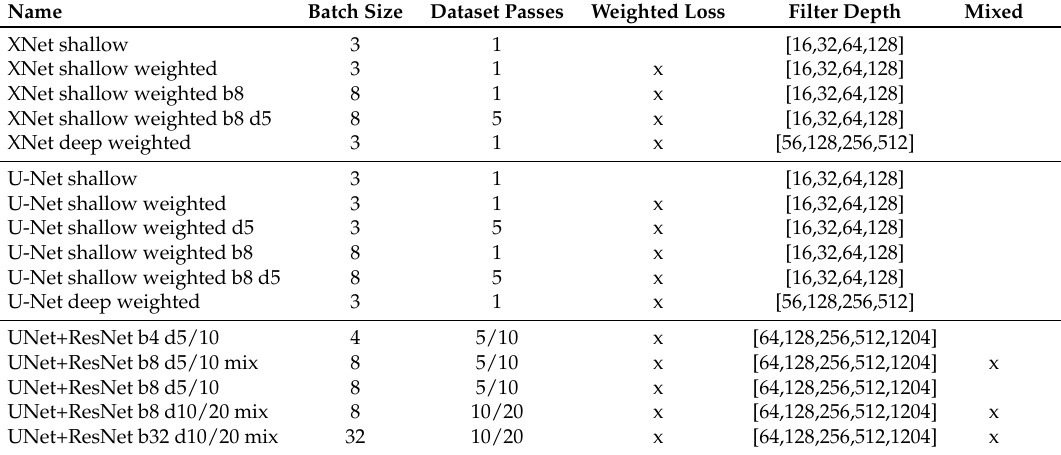
Table 3. Hyper-parameter tuning experimental setups for different architectures. Here we vary the batch size, number of times the training dataset is passed to the model during training (For the XNet and U-Net models, this number refers to the number of times the entire training dataset was passed to the model during training before Early Stopping was implemented. For the U-Net+ResNet case, the first number is the number of times the dataset was passed when training just the head nodes of the architecture, and the latter the number of times it was passed when training the entire network. In the latter case, at each epoch the validation loss was manually compared after training and the best model selected.), the use of a weighted loss function, the filter depth of the convolutional layers (where the numbers refer to the depths used symmetrically at each level of the architectures) and the use of mixed precision during